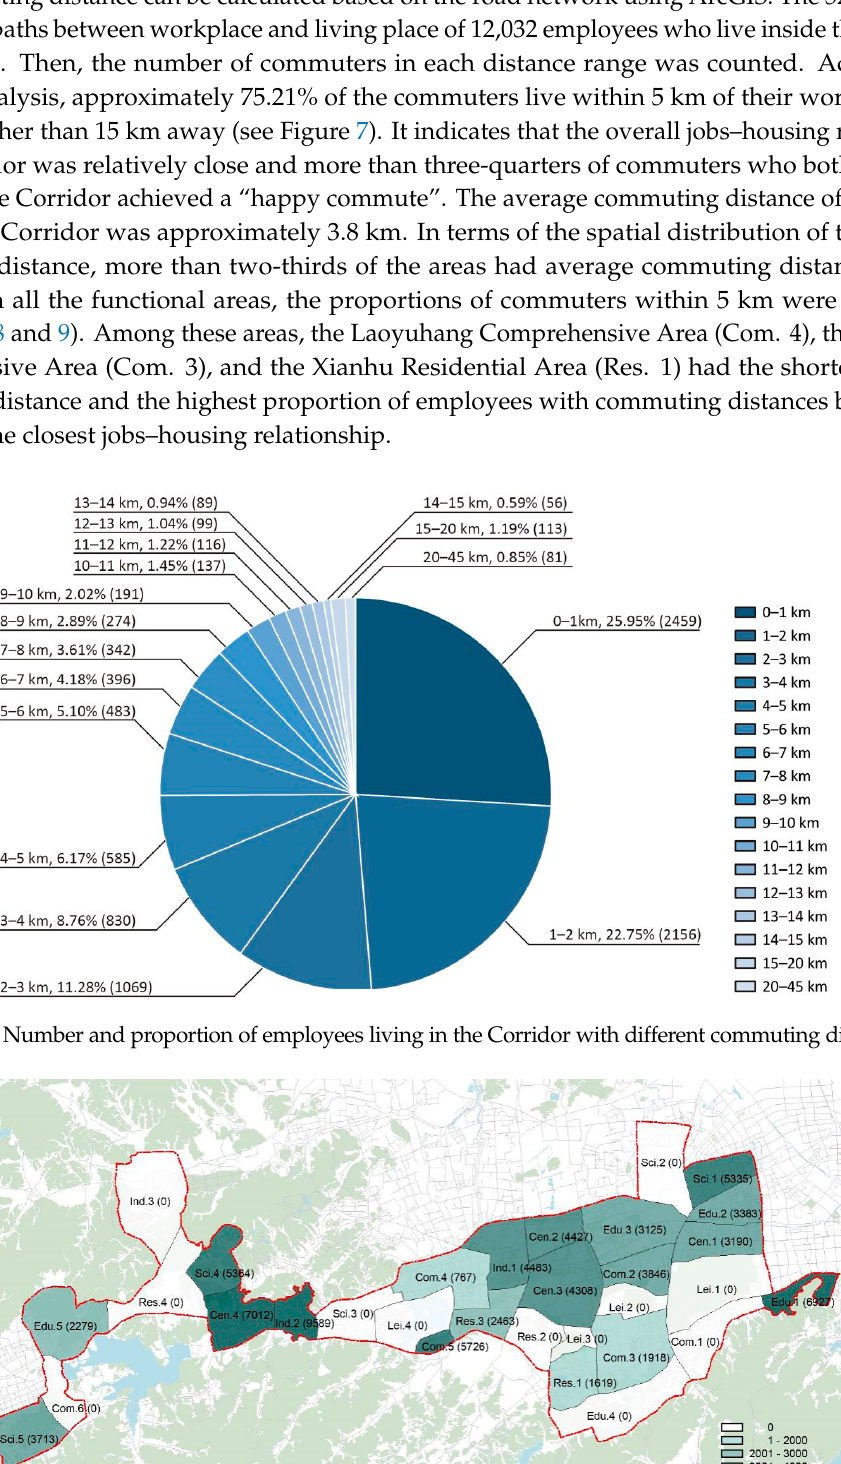
Figure 9. Proportion of happy commuters in each area in the Corridor. 4.2. Analysis of Innovative Development of Enterprises in the STPs The 16,504 sci-tech enterprises were mainly distributed along the Wenyi West Road of the Future Sci-Tech City and around the Zijingang Campus of Zhejiang University, including the Future Sci- Tech City Central Area (Cen. 3), the West Lake Sci-Tech Park Scientific Research Area (Sci. 1), the Jiangcun Central Area (Cen. 1), and the Hangzhou University City Higher Education Area (Edu. 3). There are few sci-tech enterprises in the Qingshanhu Sci-Tech City area in the west of the Hi-Tech Corridor, and only a few enterprises were concentrated in the central area (Cen. 4) and in the Cloud Manufacturing Town scientific research area (Sci. 4) (See Figure 10).